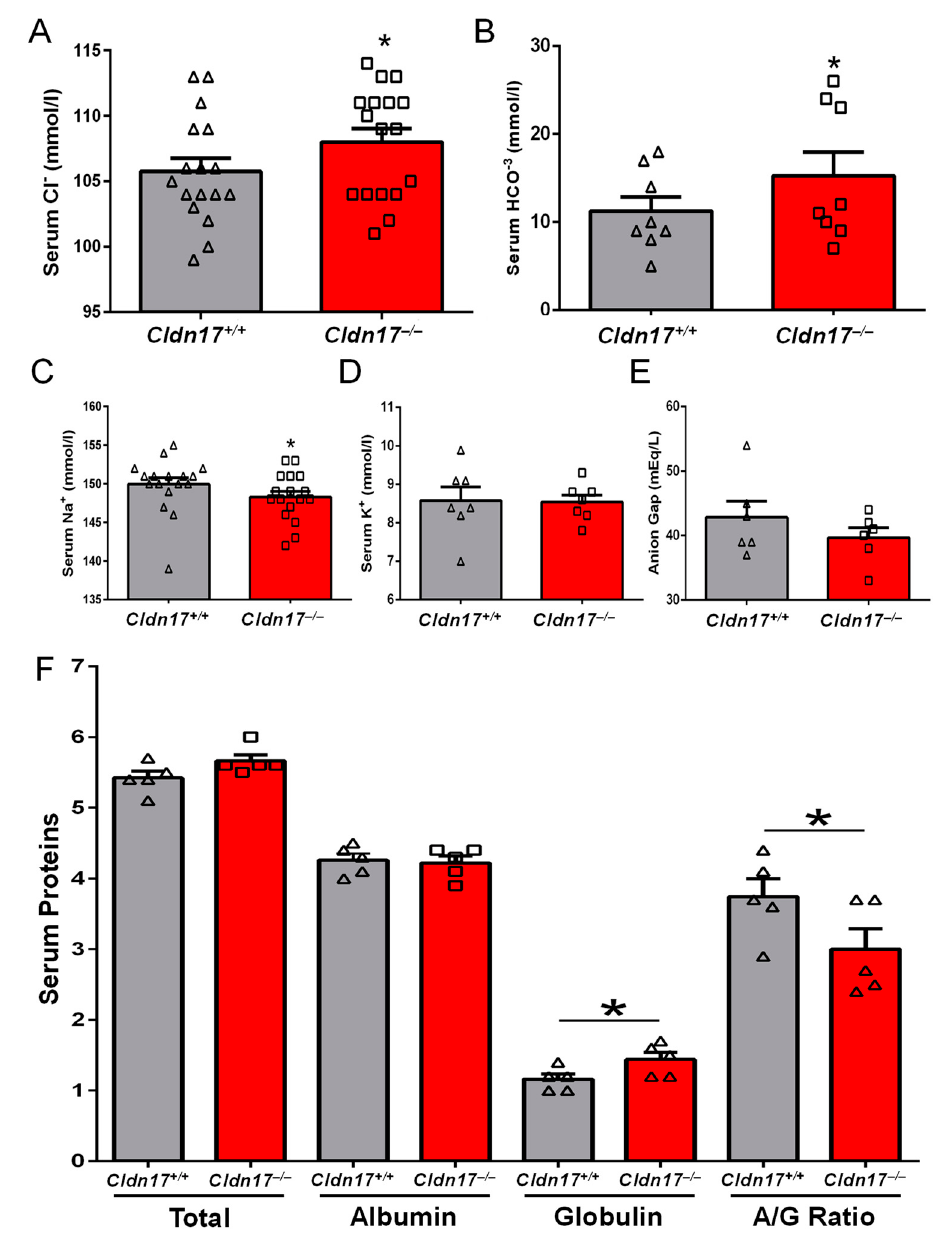
Figure 2. Loss of Cldn17 affects blood electrolytes and proteins. Bar graphs showing variations in serum levels for ( A ) chloride ( n = 17), ( B ) bicarbonates ( n = 8), ( C ) sodium ( n = 17), ( D ) potassium ( n = 7), ( E ) anion gap ( n = 6), and ( F ) proteins (total, albumin, globulin, and albumin/globulin ratio) in WT and Cldn17 − / − mice. Data presented as mean ± s.e.m.; * p < 0.05.